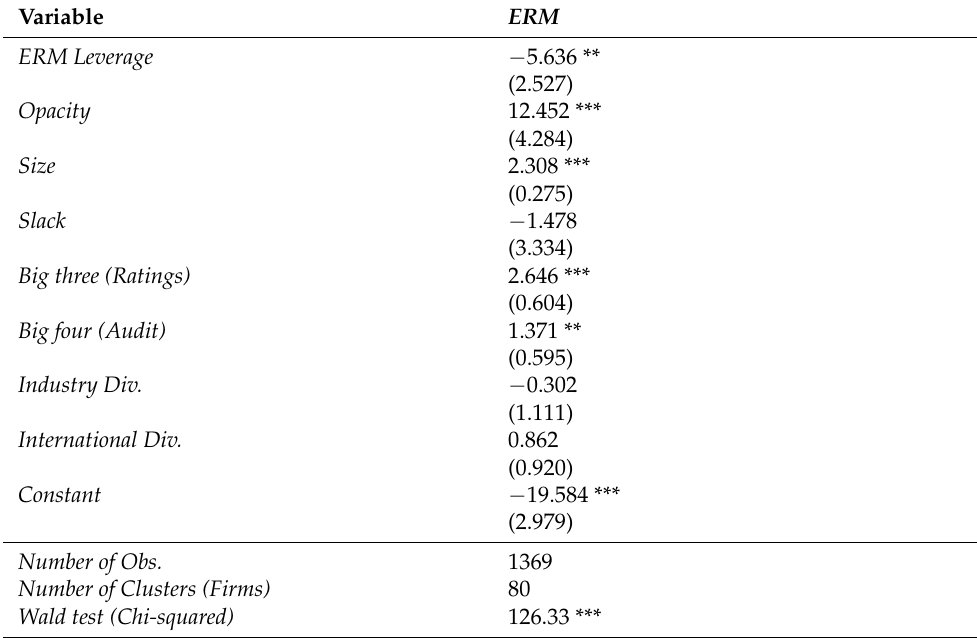
Table 4. Logistic Regression ERM